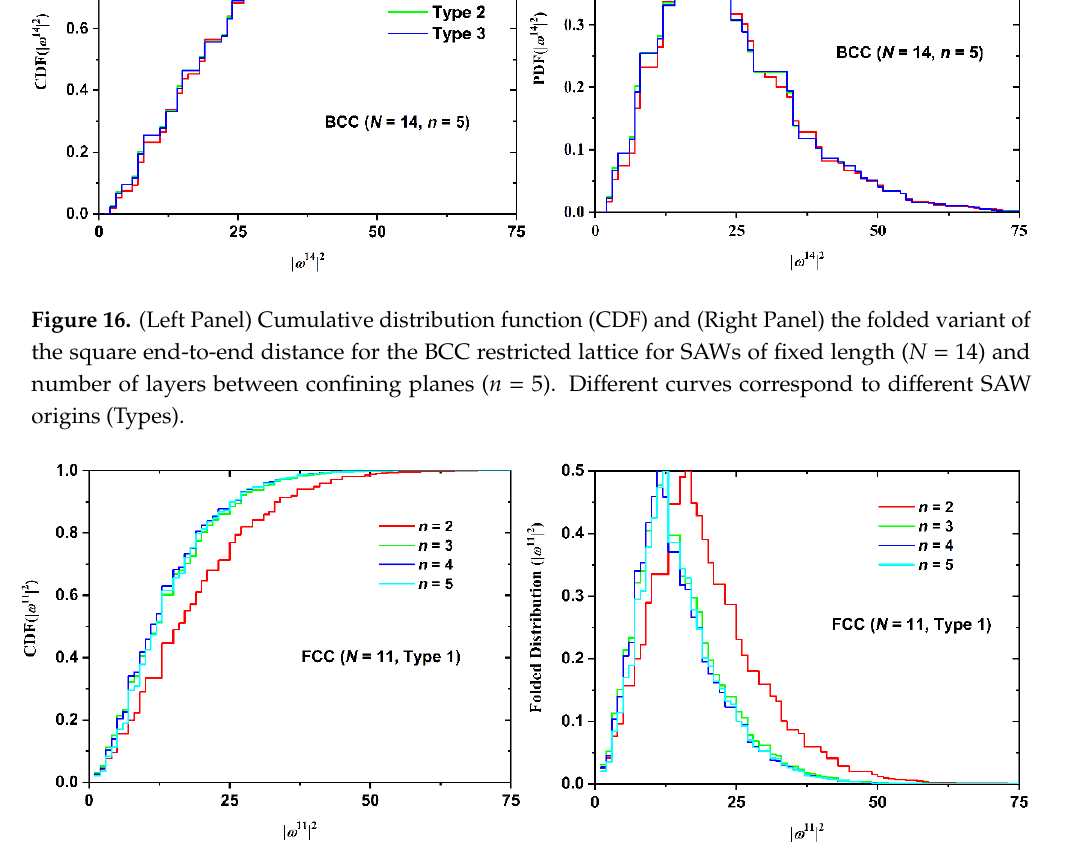
Figure 17. (Left Panel) Cumulative distribution function (CDF) and (Right Panel) the folded variant for the square end-to-end distance for the FCC restricted lattice for SAWs of fixed length ( N = 11) and point of origin (Type 1). Different curves correspond to different number of layers between the confining plates, n .